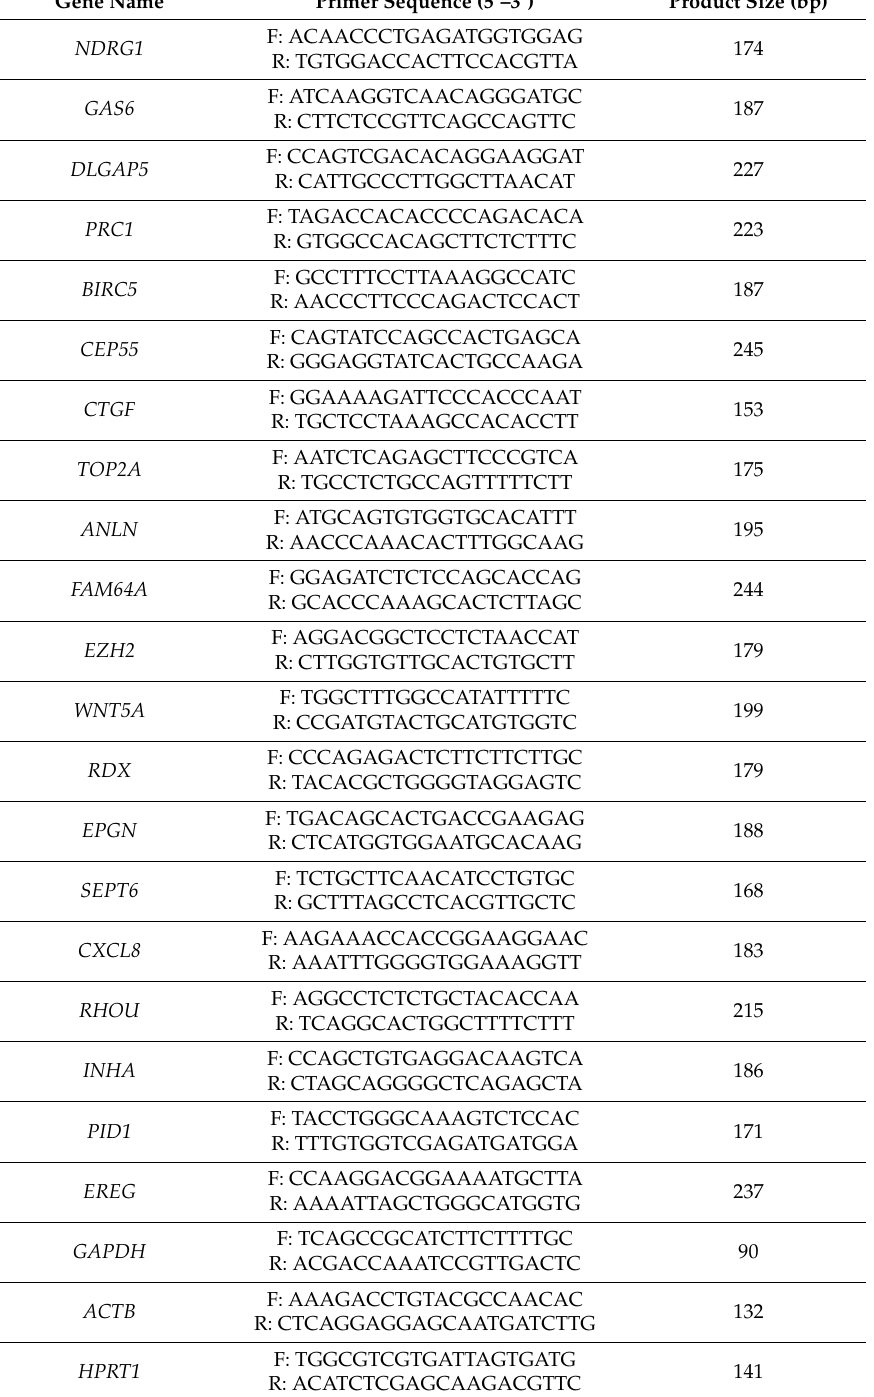
Table 1. Oligonucleotide sequences of primers used for RT-qPCR analysis: the primers of the 10 most upregulated and 10 most downregulated